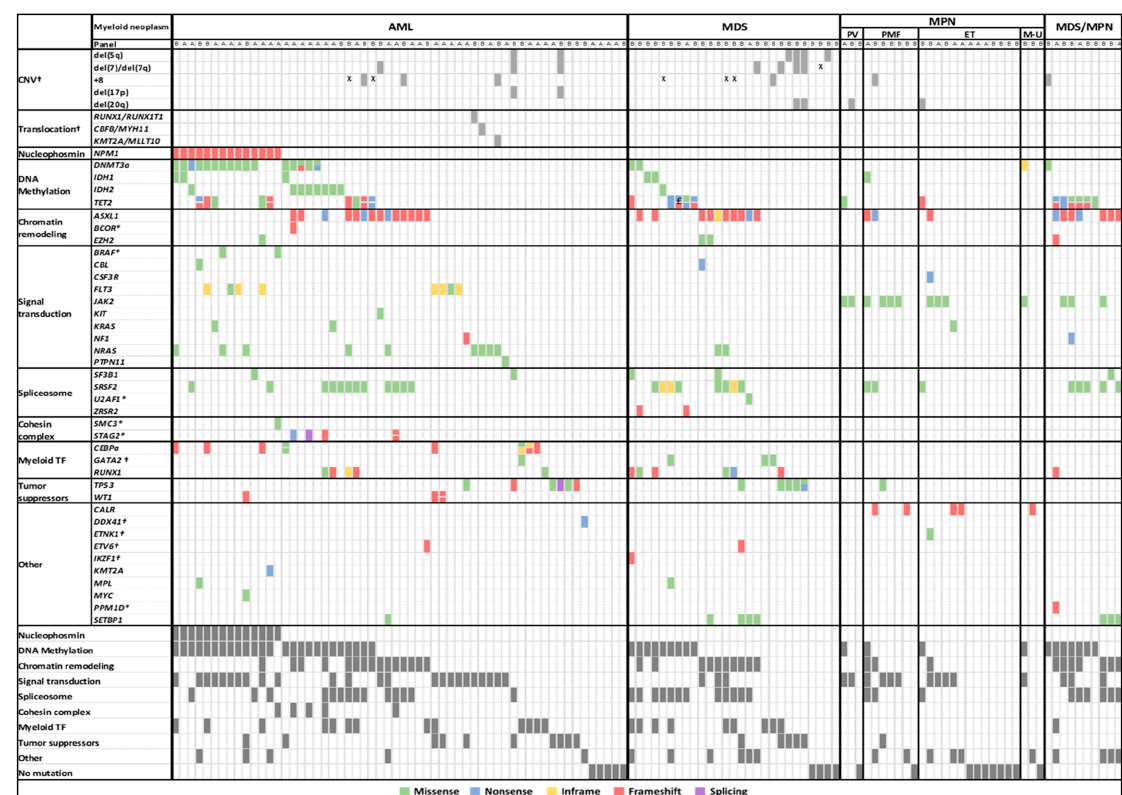
Figure 3. Variant landscape of diagnostic samples of 121 patients affected by myeloid neoplasms. Each column represents a patient. Colors represent the type of variant. *: Panel A exclusive genes ( BCOR , BCORL1 , BRAF , UA2F1 , SMC3 , STAG2, and PPM1D ). † : Panel B exclusive genes and structural alterations ( GATA2 , DDX41, and ETNK1; CNV and translocations,). χ : CNV present detected by conventional methodologies but not detected by the NGS panel. £: This patient presented a triple variant in TET2 (two nonsense and one frameshift). TF: transcription factor. AML: acute myeloid leukemia. MDS: myelodysplastic syndrome. MPN: myeloproliferative neoplasm. PV: polycythemia vera. PMF: primary myelofibrosis. ET: essential thrombocythemia. M-U: myeloproliferative neoplasm unclassifiable. MDS/MPN: myelodysplastic syndrome/myeloproliferative neoplasm. To determine the percentage of variants in genes studied exclusively by panel A ( BCOR , BCORL1 , BRAF , U2AF1 , SMC3 , STAG2, and PPM1D ), the number of patients analyzed using this panel was considered as total (50 total MN, 37 AML, 2 MDS, 8 MPN, and 3 MDS/MPN). The same procedure was performed (71 total MN, 21 AML, 25 MDS, 18 MPN, and 7 MDS/MPN) for genes exclusively analyzed by panel B ( GATA2 , DDX41, and ETNK1 ; CNV and translocations).